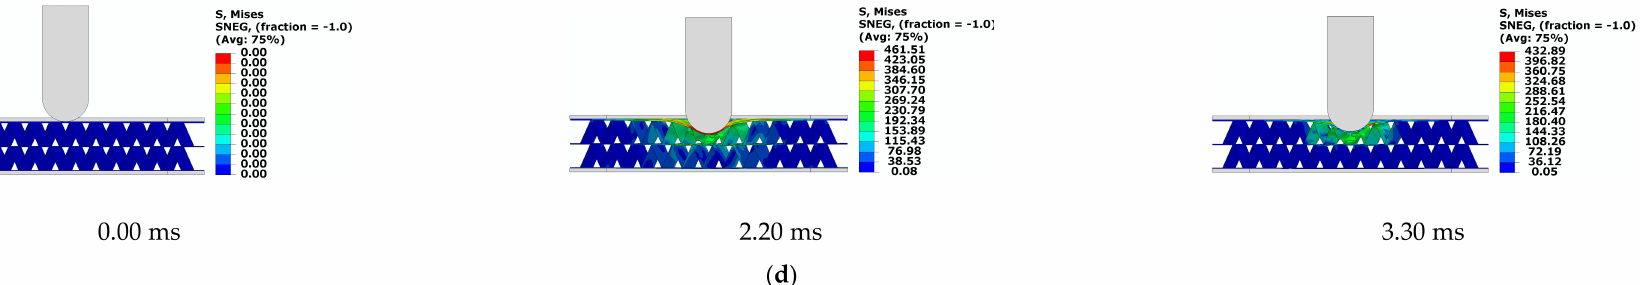
Figure 7. Deformation evolution diagram of single − layer and double − layer folded sandwich structure under different impact energies. ( a ) Deformation diagram of single − layer folded sandwich structure under 5 J impact energy; ( b ) Deformation diagram of double − layer folded sandwich structure under 5 J impact energy; ( c ) Deformation diagram of single − layer folded sandwich structure under 40 J impact energy; ( d ) Deformation diagram of double − layer folded sandwich structure under 40 J impact